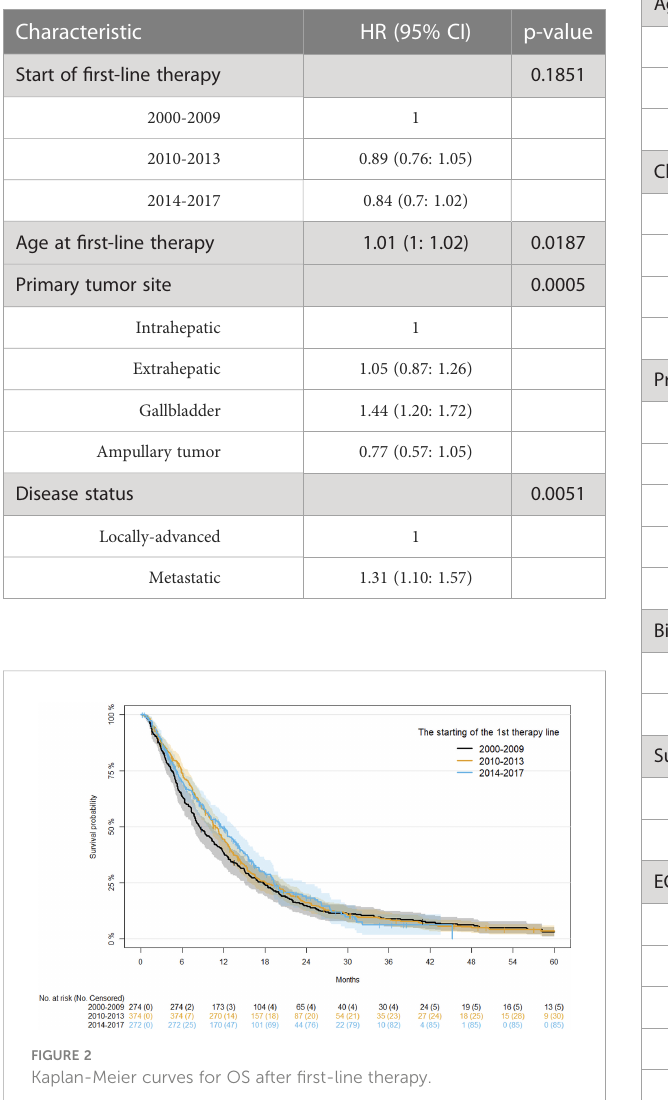
TABLE 4 Cox model after adjusting for confounding factors on OS for fi rst-line therapy (N=922).